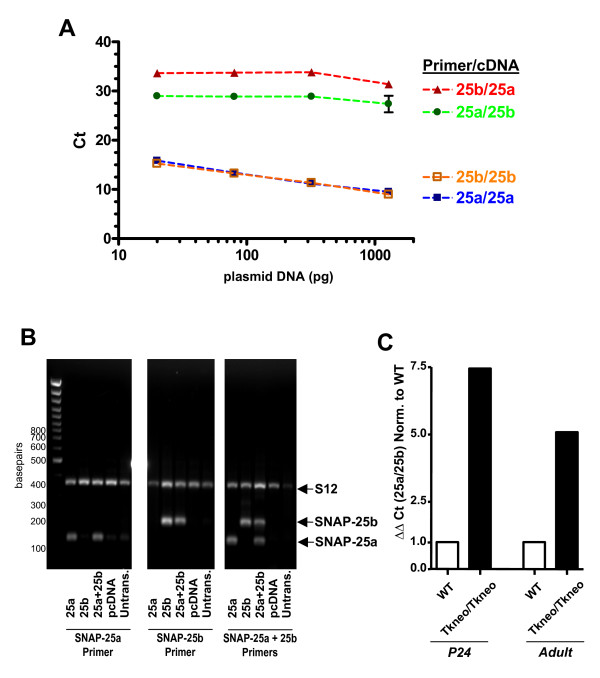
Quantitative real-time PCR assay of SNAP-25 isoform transcripts. Quantitative RT-PCR demonstrated specific and equivalent amplification of SNAP-25 isoform sequences using primers designed to exploit nucleotide sequence differences between SNAP-25a and 25b (see Table 2). Panel A, Calibration curve of quantitative RT-PCR performed using primers sets on SNAP-25 isoform cDNA. Ct values (triplicates ± SEM) obtained for each primer/cDNA plasmid pair were plotted versus the amount of DNA template on a log scale to demonstrate the linear relationship between amplification and DNA input. Robust and equal amplification of each SNAP-25 isoform cDNA was detected only with the appropriate primer set and corresponding plasmid (SNAP-25a: 25a/25a, blue closed squares; and SNAP-25b 25b/25b, orange open squares). Only non-specific, negligible amplification (CT values >30) was obtained from non-corresponding primer/plasmid sets (e.g. 25a/25b, green triangles; 25b/25a red circles). Panel B, RT-PCR performed on RNA of transfected cells. COS7 cells (1.5 × 105 cells/well of a 12 well plate) were transfected with equivalent molar amounts (~1 μg/well) pCDNA3 expression plasmids bearing SNAP-25 isoforms [15], or the empty vector (pCDNA), using Lipofectamine (Invitrogen, Carlsbad CA, USA). cDNA prepared from RNA (1 μg) extracted from the transfected or untransfected (Untrans) control cells was amplified using the indicated isoform specific reverse primer, either individually or together (25a+25b), by conventional end-point reverse transcriptase PCR (40 cycles, see Methods). Amplification using a primer set to S12 rRNA protein transcripts served as a positive control. The size of the isoform specific amplicons (SNAP-25a 149 bp; SNAP-25b, 176 bp) is due to the different positions of isoform-specific reverse primers relative to the common forward primer, panSNAP25. The lack of a band in the mismatched primer/template lanes reflects the specificity of the PCR reaction. Panel C, Quantitative RT-PCR using total RNA preparations from cortex of wild type (WT, white bar) and SNAP-25a overexpressing knockin mutant (Snap25tkneo, black bar) mice. The relative overexpression of SNAP-25a transcripts in the homozygous mutant (Tkneo/Tkneo) samples, expressed as ΔΔCt (25a/25b) normalized to wild type (WT), was calculated from the SNAP-25 isoform amplification relative to β-actin (ΔCt value) and then deriving the relative ratio of their amplification rates (ΔΔCt). The ratio of SNAP-25a to SNAP-25b (e.g. 25a/25b) obtained from the mutant was then normalized to wild type (set at 1.0) to obtain a fold increase of SNAP-25a expression in these mutant mice. This increased level of SNAP-25a isoform transcripts in the mutant cortex RNAs, seen in both young (P24) and adult (P124), is consistent with values previously reported for these mice [22] confirming the specificity of each primer set and their use in assaying the expression of SNAP-25 isoforms in brain tissue.